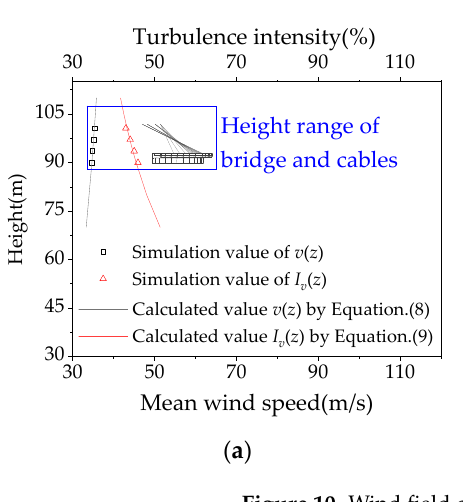
Figure 10. Wind field characteristics comparison between simulation and calculated values. ( a ) Mean wind speed and turbulence intensity, ( b ) Wind speed spectrum.